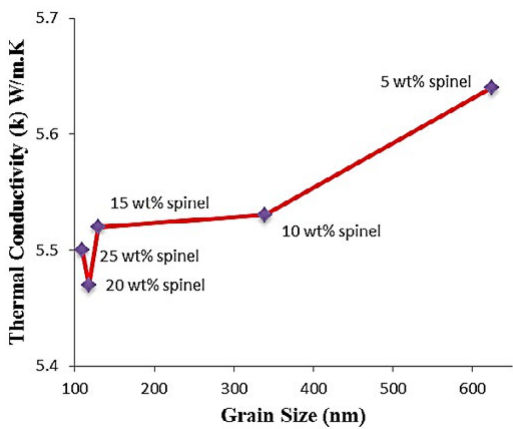
Fig. 2. The grain size dependence of the coefficient of thermal conductivity for Y-PSZ with different MAS additions.